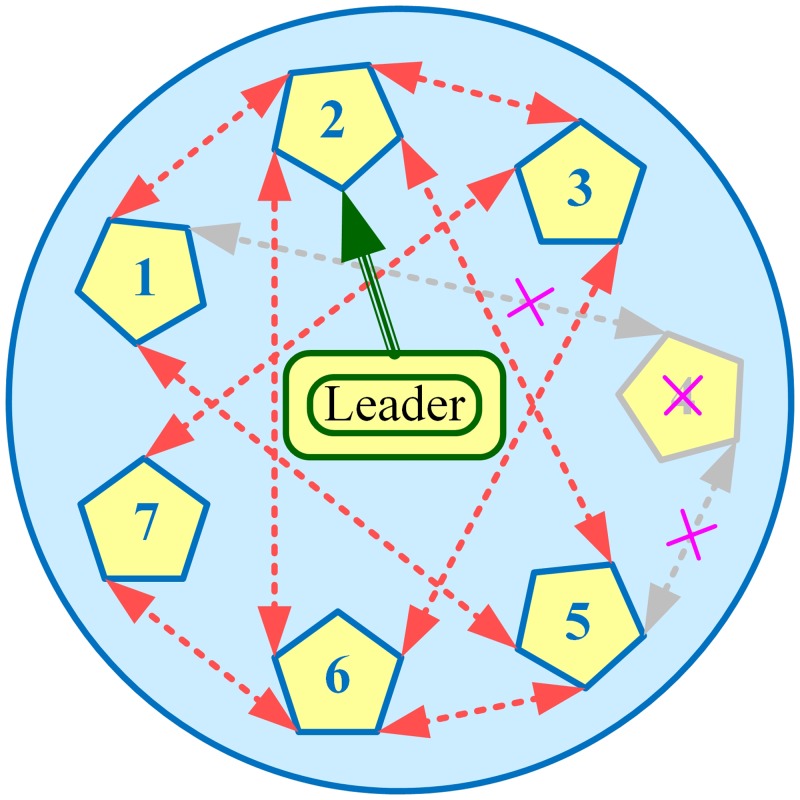
Communication graph when BESS4 is taken out of service.